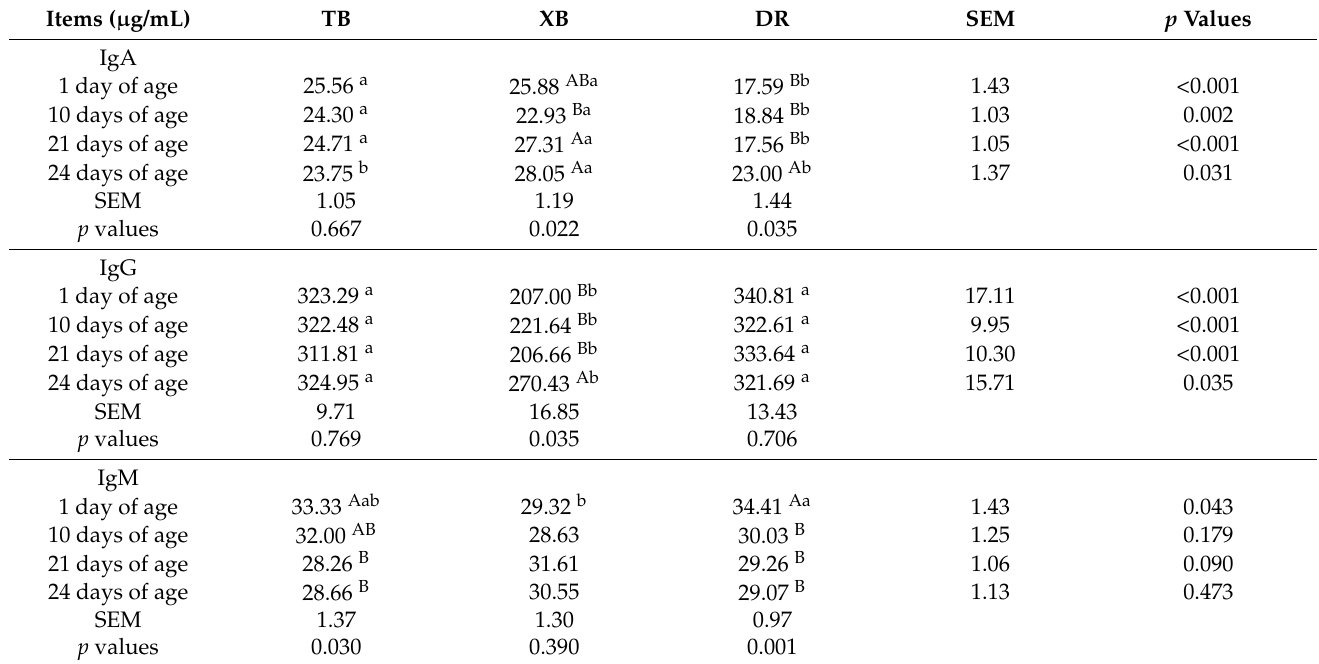
Table 2. Changes in plasma immunoglobulin levels of different pig breeds during suckling and weaning